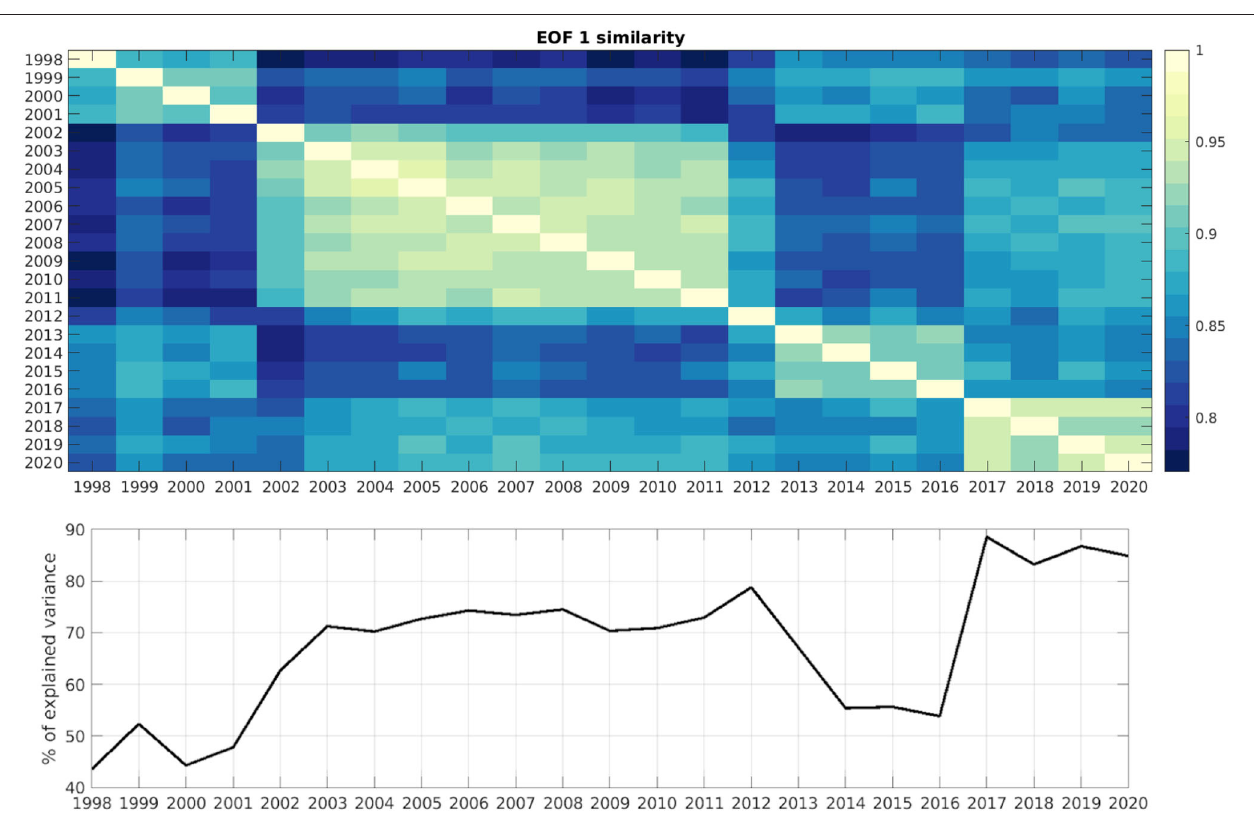
FIGURE 8 | (Top) Correlation between each year first EOF CHL mode and all the other years. (Bottom) Percentage of explained variance retained in the DINEOF interpolated